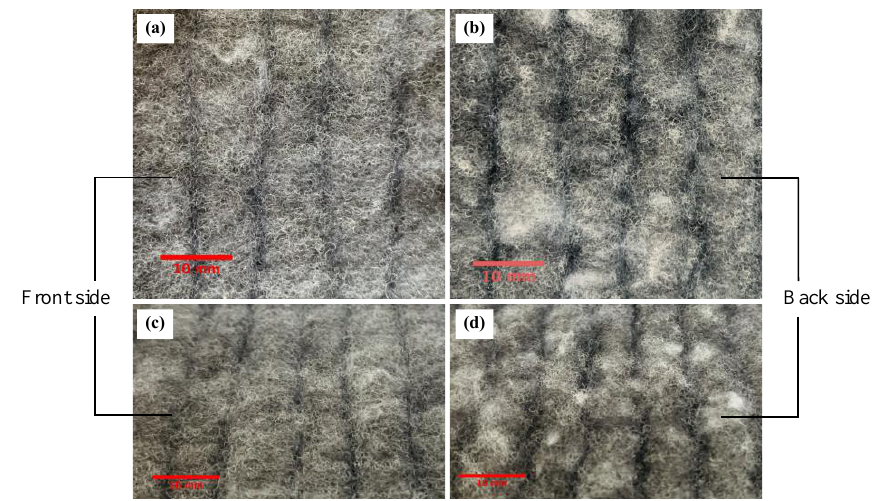
Figure 5. The surface texture of polyester fibrous panel sample: ( a , c ) front side, and ( b , d ) back side.